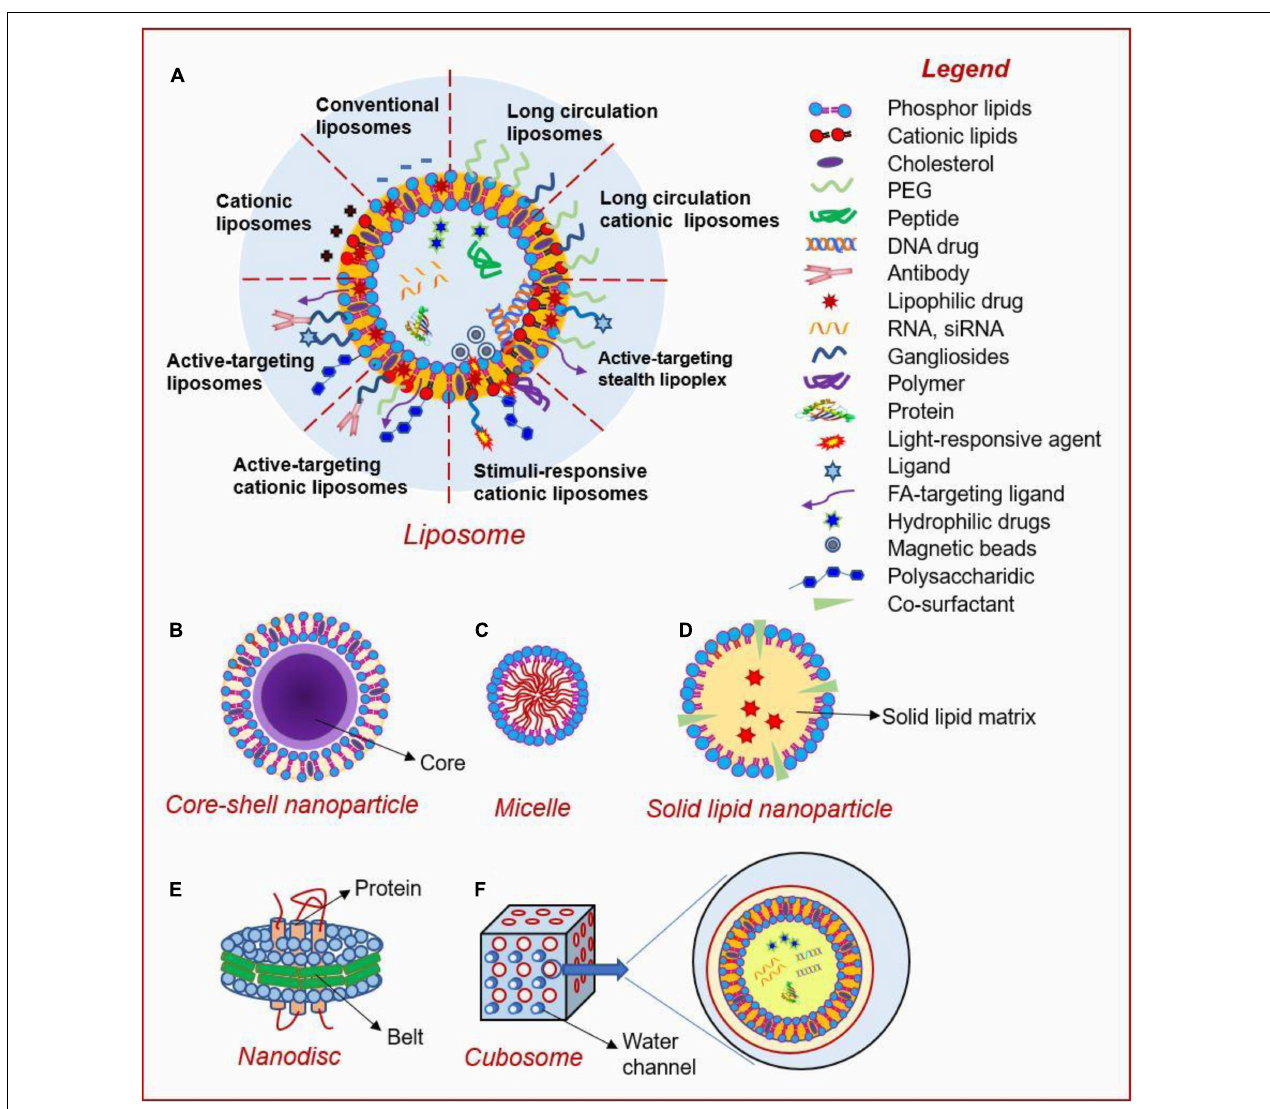
FIGURE 3 | Types and structures of lipid-based nanoparticles (Yang and Merlin, 2020). Current lipid-based nanoplatforms include: (A) liposome, (B) core-shell nanoparticle, (C) micelle, (D) solid lipid nanoparticle, (E) nanodisc, and (F)